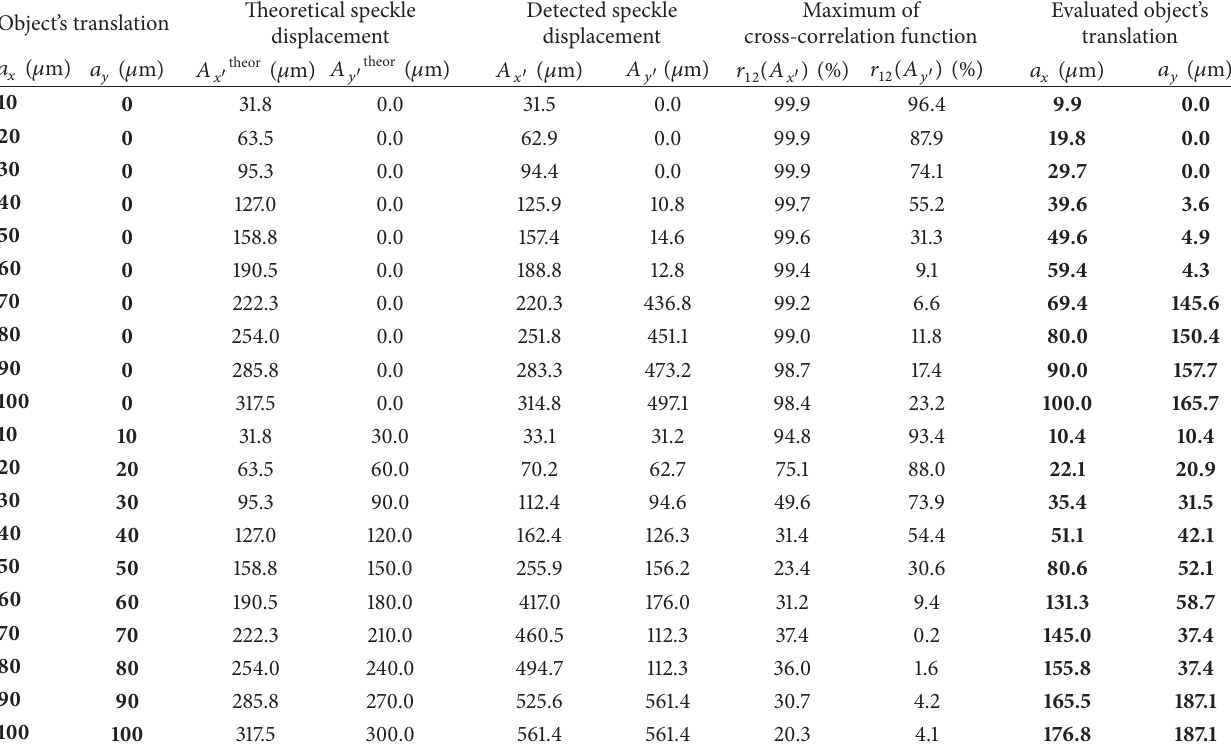
Table 1: Object’s translation components 𝑎 𝑥 and 𝑎 𝑦 computed from acquired positions 𝐴 𝑥 󸀠 and 𝐴 𝑦 󸀠 of the maxima 𝑟 12 (𝐴 𝑥 󸀠 ) and 𝑟 12 (𝐴 𝑦 󸀠 ) of normalized cross-correlation function 𝑟 12 of intensities 𝐼 1 and 𝐼 2 by means of (4) and (5). Initial parameters of the computer simulation are according to Figure 1: 𝑉 𝑥 = 𝑉 𝑦 = 4 mm, 𝑉 𝑥 󸀠 = 𝑉 𝑦 󸀠 = 8 mm, 𝑚 𝑖 = 𝑛 𝑖 = 400 , 𝑚 = 𝑛 = 570 , 𝐿 𝑜 = 0.4 m, 𝐿 𝑠 = 0.2 m, 𝜃 𝑜 = 30 ∘ , 𝜔 𝑜 = 60𝜇 m, and 𝜆 = 632.8 nm. Mean speckle size of detected speckle pattern oriented along 𝑥 󸀠 - and 𝑦 󸀠 - axes direction is 𝛼 For the sake of clarity, the values of object’s translation components (columns 1 and 2) and corresponding evaluated values (columns 9 and 10) are highlighted by bold